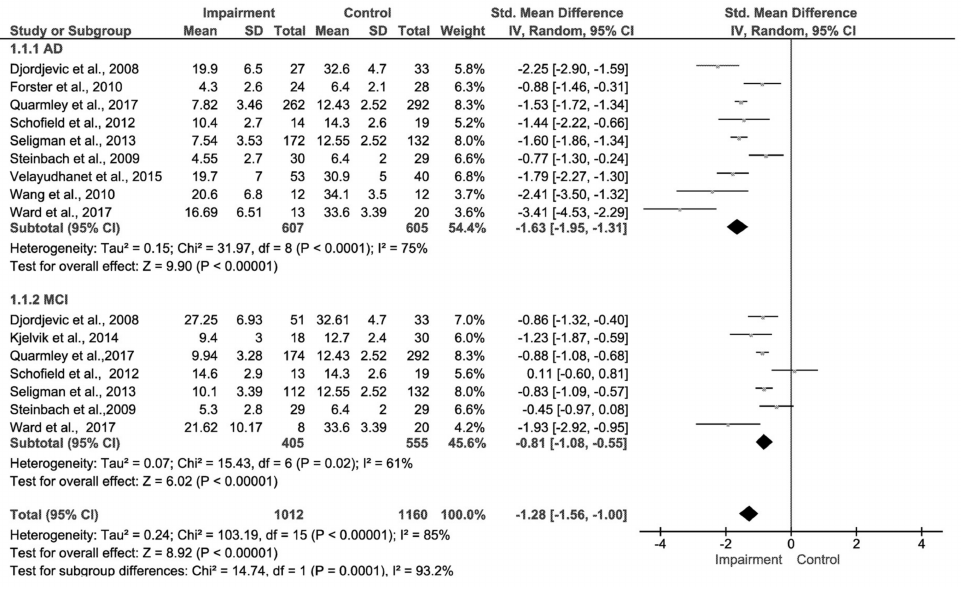
Figure 7. Subgroup analysis forest plot comparing the effect sizes of the two meta-analyses conducted.